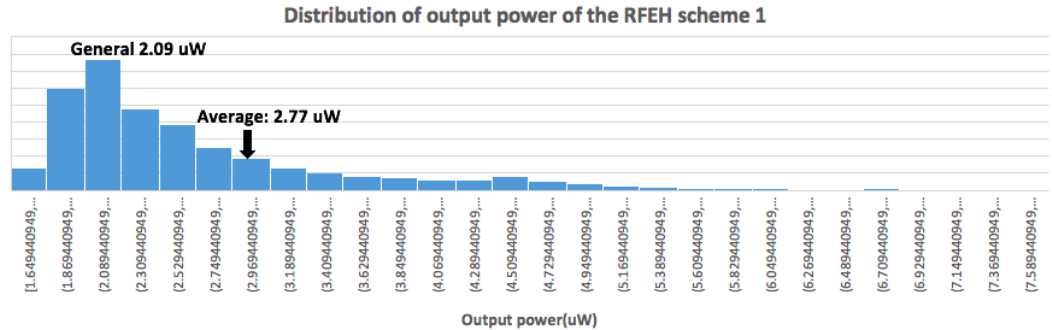
Figure 24. Output power of scheme 1 at 82 k Ω loads as measured for 1 h.